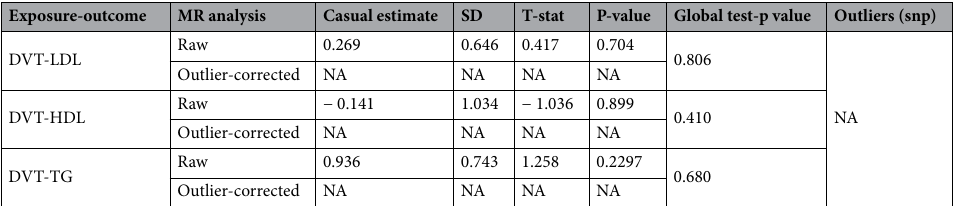
Table 4. MR-Presso results (VT—classical lipids). SD standard deviation, SNP single nucleotide polymorphism, MR-PRESSO MR-Pleiotropy Residual Sum and Outlier method, DVT deep venous thrombosis, LDL low density lipoprotein, HDL high-density lipoprotein, TG